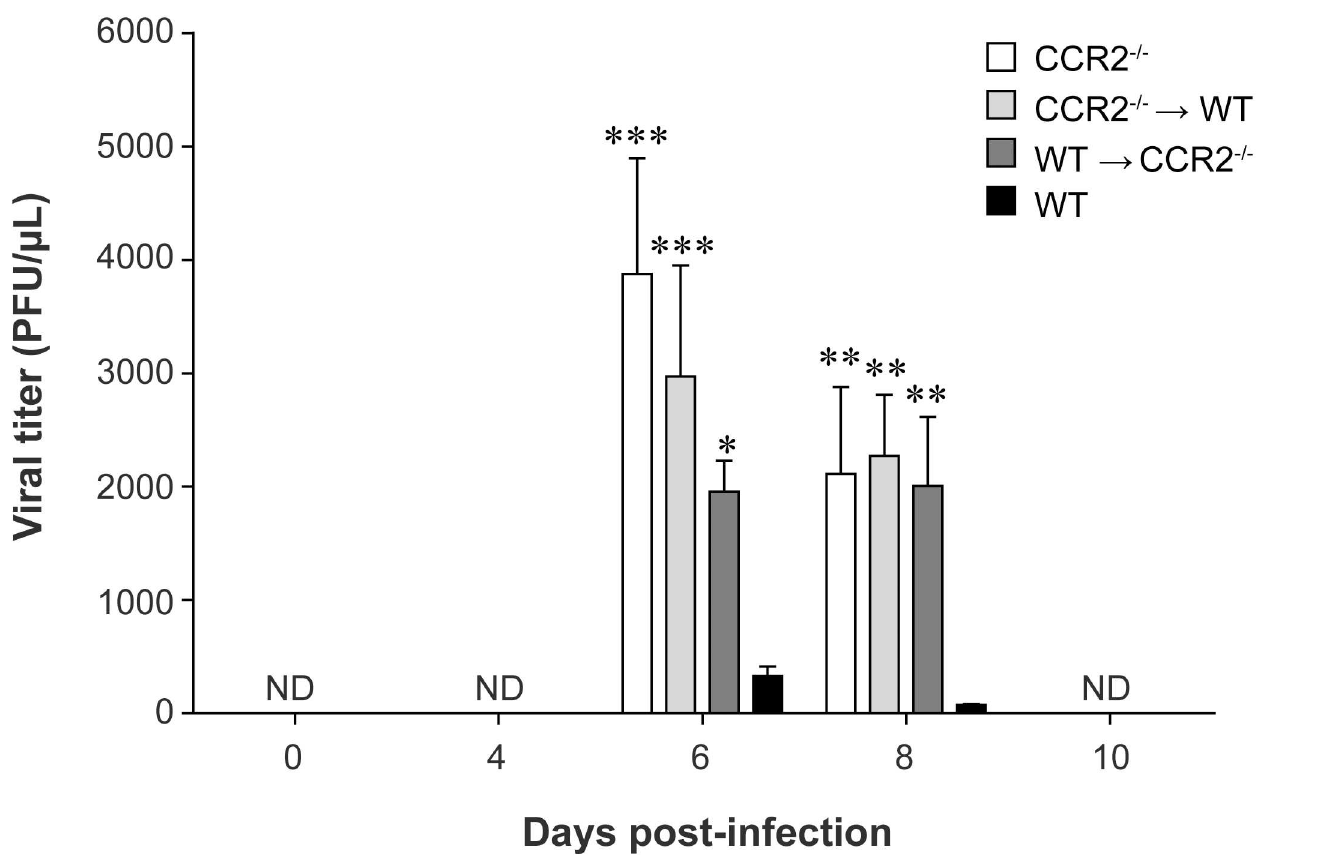
Fig 2. Impact of CCR2 deficiency in resident cells of the CNS or in the hematopoietic systemon the control of viral replication during HSE. Wild- type (WT) C57BL/6, CCR2 -/- , CCR2 -/- ! WT and WT ! CCR2 -/- mice were sacrificedprior to (day 0) and on days 4, 6, 8 and 10 followingintranasalinfection with 1.2x10 6 PFU of HSV-1. Viral titers were measuredin brain homogenates by a standardplaqueassay on Vero cells. Results are reportedas PFU/ μ L of brain homogenates and represent the means ± standard deviations of 4 to 5 mice per group at each time point. Statistical analyseswere performed using a one-way analysisof variance (ANOVA) with Tukey’s multiplecomparisonpost-test. Statistically significantresults comparedto those for the WT group are indicatedas follows: * , P < 0.05; ** , P < 0.01; *** , P < 0.001.ND, not detected.